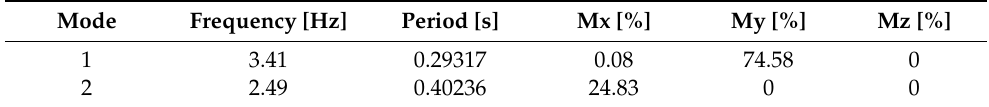
Table 4. Modal analysis information.